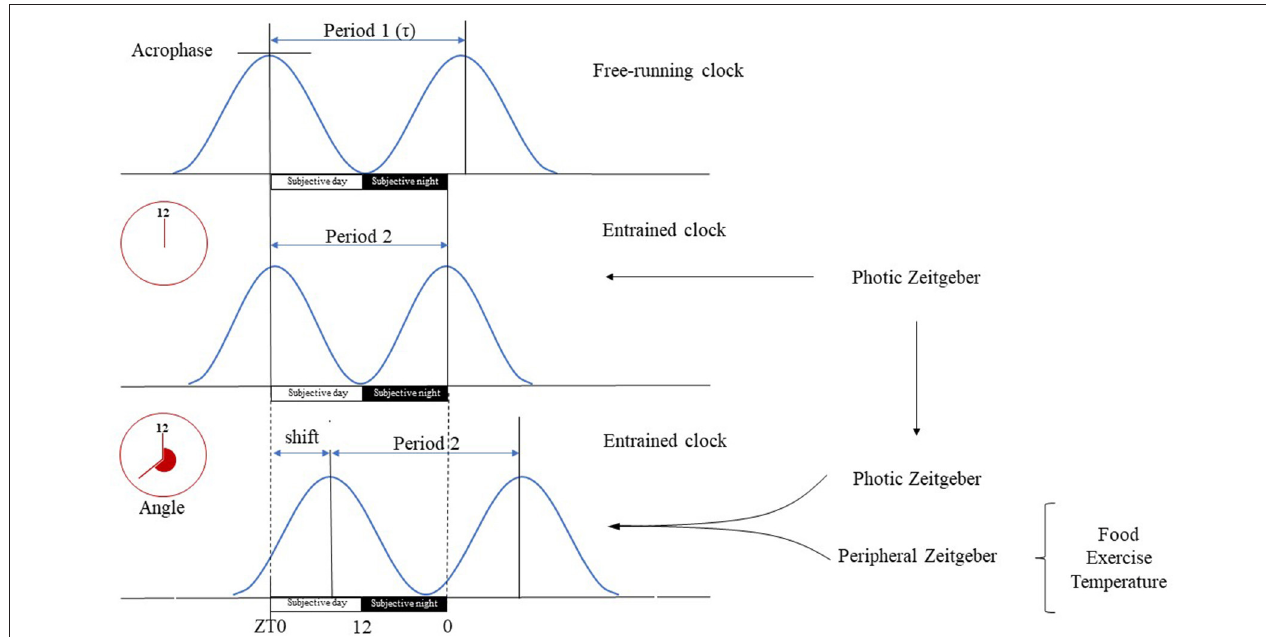
FIGURE 2 | Basic terms of circadian physiology. Dedicated cells of the SCN have self-sustained circadian pacemaker activity that is propagated to other cerebral tissues and peripheral organs. The intrinsic period of these oscillations ( τ ) is generally longer than the 24-h long geophysical circadian time period. In the absence of Zeitgebers, the master clock is free running, e.g., its period length is unaltered and driven solely by its pacemaker activity. Therefore, the free running clock will be misaligned with the environmental light-day photoperiod, yielding a phase angle of entrainment, e.g., difference between the timing of circadian oscillations and that of the photic input. The magnitude of the phase angle depends on the difference deviation of τ from the 24-h period, the strength of the Zeitgeber and the individual’s responsiveness. The SCN is mainly entrained by photic input, e.g., light can align the intrinsic period of oscillations with the environment. Peripheral organs on the other hand have only slave oscillators, e.g., their activity becomes arrhythmic in the absence of entrainment. Their oscillations are entrained by the neural, hormonal etc. outputs of the SCN, and by peripheral, environmental signals specific for the given tissue (e.g., cold, fast, exercise). Tissue specific entrainment may cause a phase shift of peripheral oscillations with respect to the master clock, leading to a discrete displacement of the oscillation along the time axis. Subjective day is the part of the circadian period during which the organism is exposed to illumination (Zeitgeber time 0–12h), while subjective night is the segment of the circadian period when it is dark (Zeitgeber time